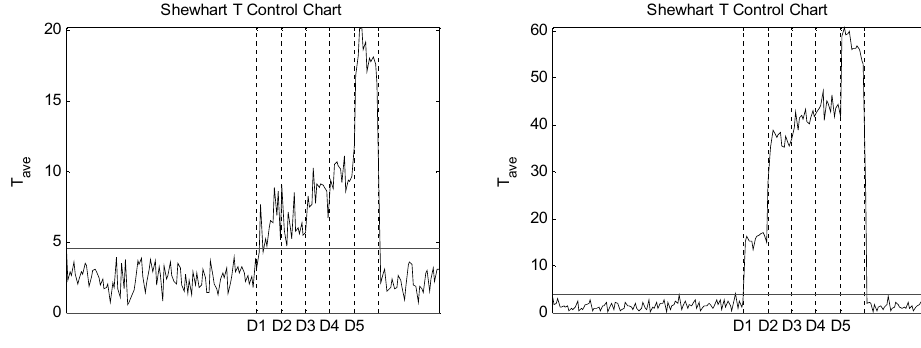
Fig. 6. Damage location 1. Left: AR coefficients. Right: absolute transmissibilities.